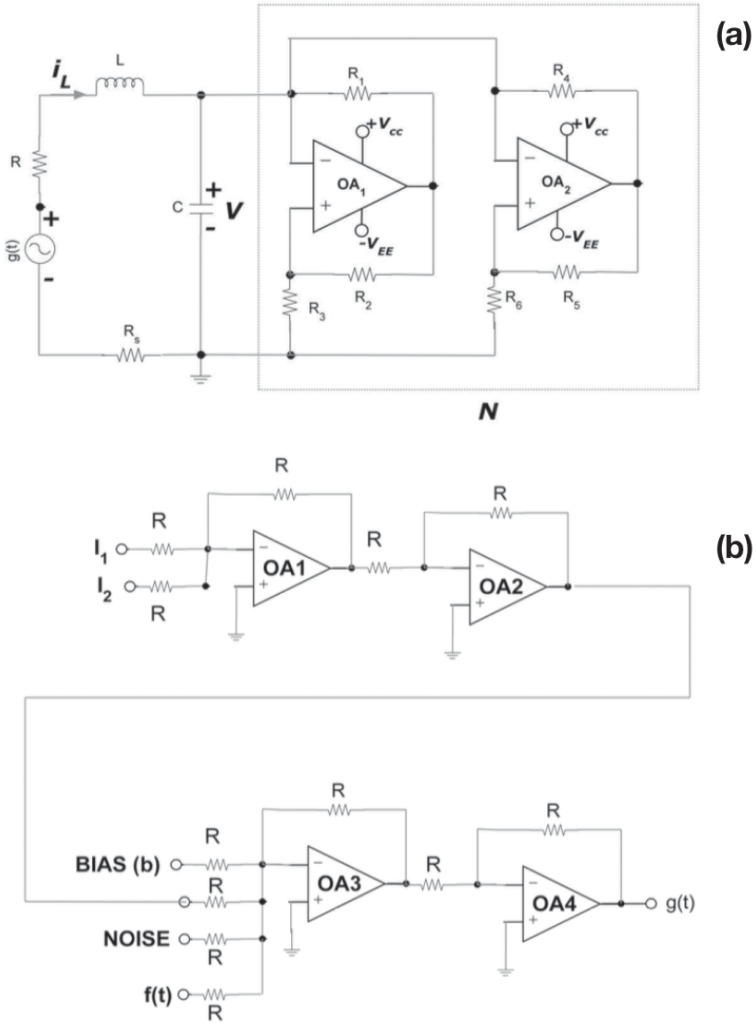
(a): Realization of MLC circuit using two op-amps (AD712, TL082, AD844, or equivalent) and six linear resistors to implement the Chua’s diode (N). The resistors R = 1340 Ω, R1 = R2 = 22 kΩ, R3 = 3.3 kΩ, R4 = R5 = 220 Ω, R6 = 2.2 kΩ and Rs = 20 Ω. The capacitor C = 10 nF and the inductor L = 18 mH (TOKO type 10RB or equivalent). Here g(t) is the input driving signal, the capacitor voltage is V(t) and the inductor current is iL. The current iL is sensed through the resistor Rs to give the voltage VL [1]. (b) Circuit for generating the driving signal g(t). Here op-amps OA1—OA4 are realized with AD712. All the resistors are fixed as R = 10 kΩ. The power-supply to op-amps and the bias voltage (b) are drawn from Agilent or Keysight E3631A DC Power Supply. The sinusoidal signal f(t) and the noise signal are drawn from Agilent or Keysight 33522A, Function/Arbitrary Waveform Generator.